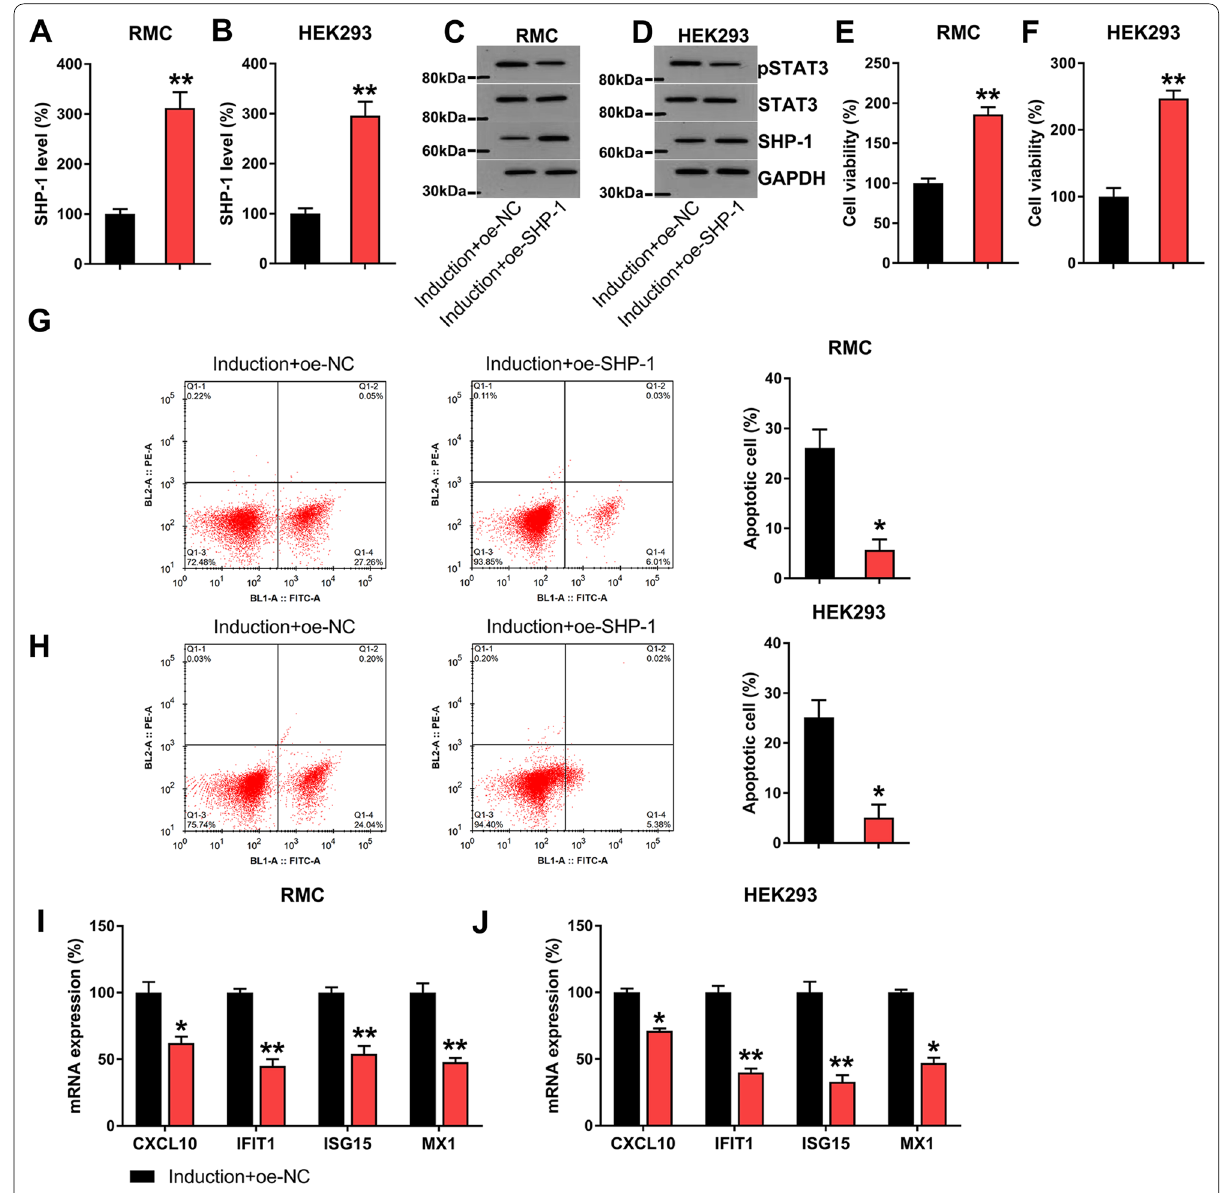
Fig. 7 Influence of SHP‑1 overexpression on viability, apoptosis, and IFN‑associated inflammation of RMCs and HEK293 cells. RMC and HEK293 cells were transfected with an SHP‑1‑overexpressing vector or NC vector for 24 h, followed by treatment with 1,000 units/mL IFN for 24 h. Expression of ( A , B ) SHP‑1 was measured in cells with different transfection constructs by RT‑qPCR (biological replicates, 2; technical replicates, 3; repeat time, 3). C , D WB was performed to detect SHP‑1, STAT3, and phosphorylated STAT3 levels in RMCs and HEK293 cells (biological replicates, 1; technical replicates, 3; repeat time, 3). E , F cell viability of RMCs and HEK293 cells were determined by MTT assay (biological replicates, 1; technical replicates, 3; repeat time, 3). G , H the number of apoptotic cells was evaluated by flow cytometry (biological replicates, 1; technical replicates, 3; repeat time, 3). I , J expression of mRNA for CXCL10, IFIT1, ISG15, and MX1 gene in RMCs and HEK293 cells as determined by RT‑qPCR (biological replicates, 2; technical replicates, 3; repeat time, 3). Results are expressed as the mean SEM for technical replicates. *P < 0.05, **P < 0.01 vs. the indicated ±